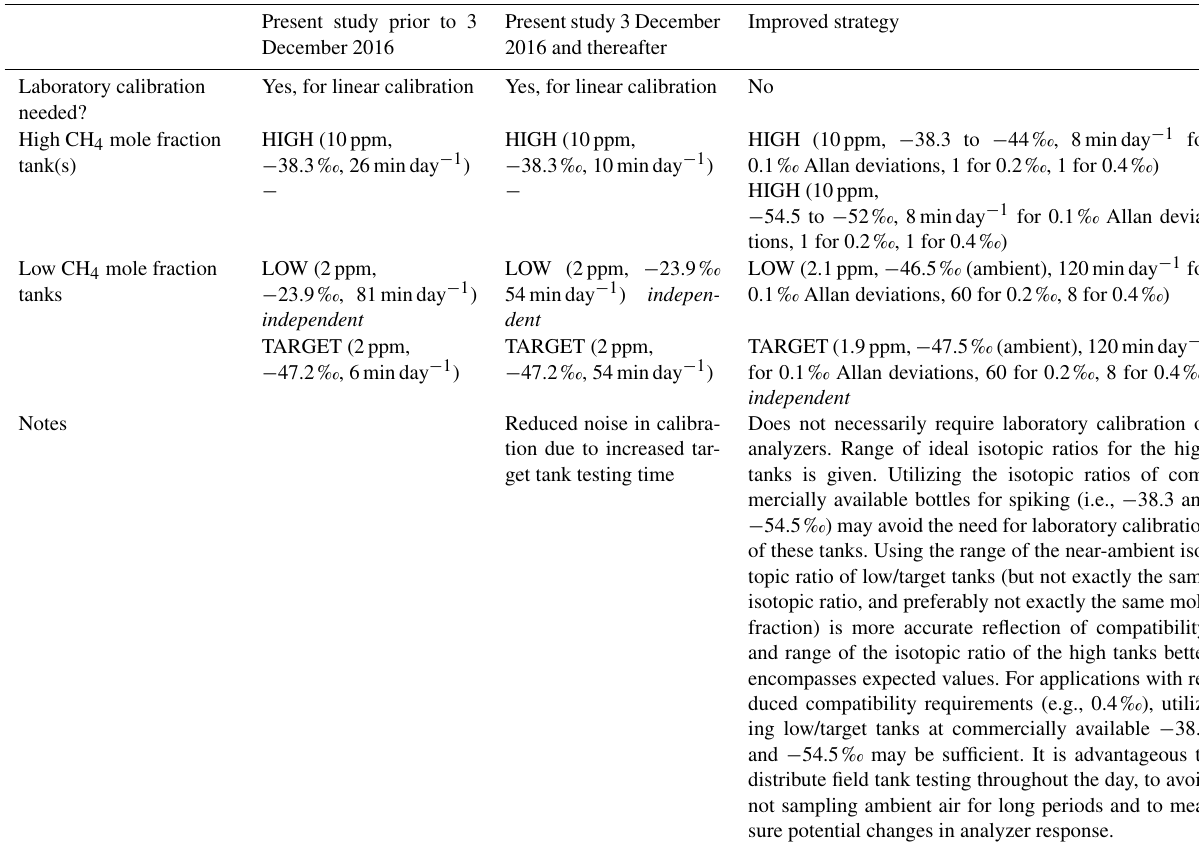
Table 4. Possible field tanks and sampling strategies, including those employed in the present study. The “Improved strategy” column suggests a possible strategy in which three field tanks and one independent tank are employed, and thus laboratory calibration is not required. Estimated tank testing times (excluding transition times) are listed for various compatibility